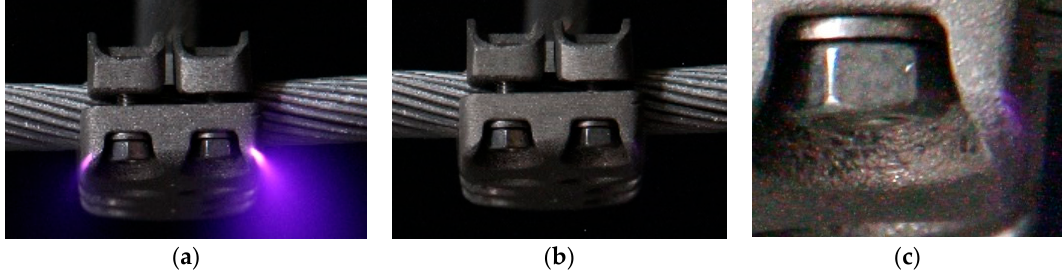
Figure 9. Corona tests. ( a ) Positive dc corona at +90 kV; ( b ) Positive dc corona near the extinction point